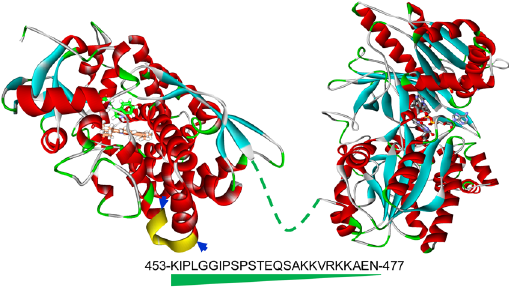
Figure 1. Schematic depiction of chimeric TxtE-BM3R constructs with variable linker length or a swapped loop (yellow). The structure of human NADPH–cytochrome P450 reductase (PDB: 3QE2, right) represented not-available BM3R structure along with TxtE (PDB: 4TPO, left). The 25-AA linker of P450BM3 is shown as a green dash line (middle) along with the amino acid